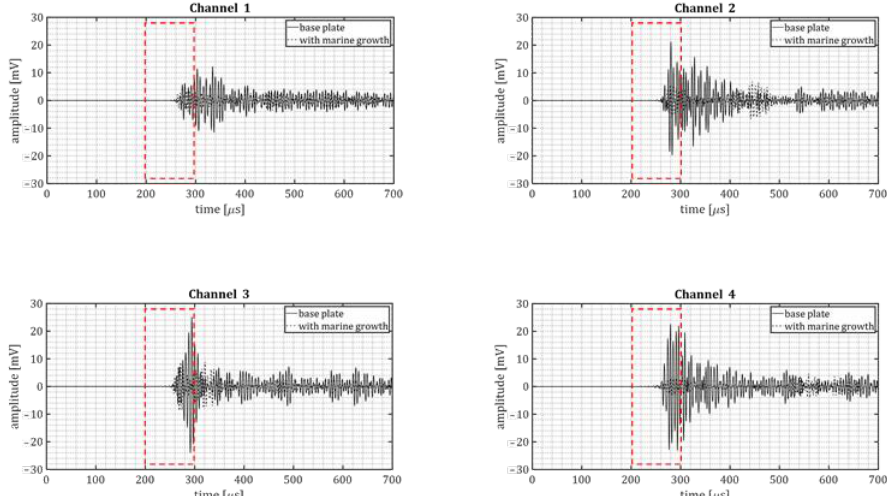
Figure 7. Samples of the processed pencil lead breaks signals for baseline plate and marine growth covered plate. Red dashed box indicates the FFT calculation window, which intends to exclude, as much as possible, the reflections and scatterings of the signals caused by finite dimensions of the tank and specimens.